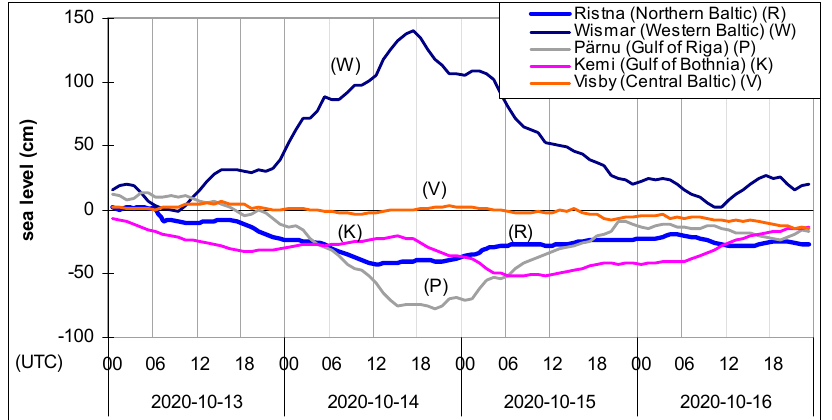
Figure 3. Sea level changes for representative stations in the main sub-basins of the Baltic Sea from 13 to 16 October 2020. (Storm surge at the Wismar station in the Western Baltic, and low sea levels at the northeastern Baltic coasts). Table 1. Features of the low pressure system and parameters of the storm surge analyzed in the period of 13–16 October